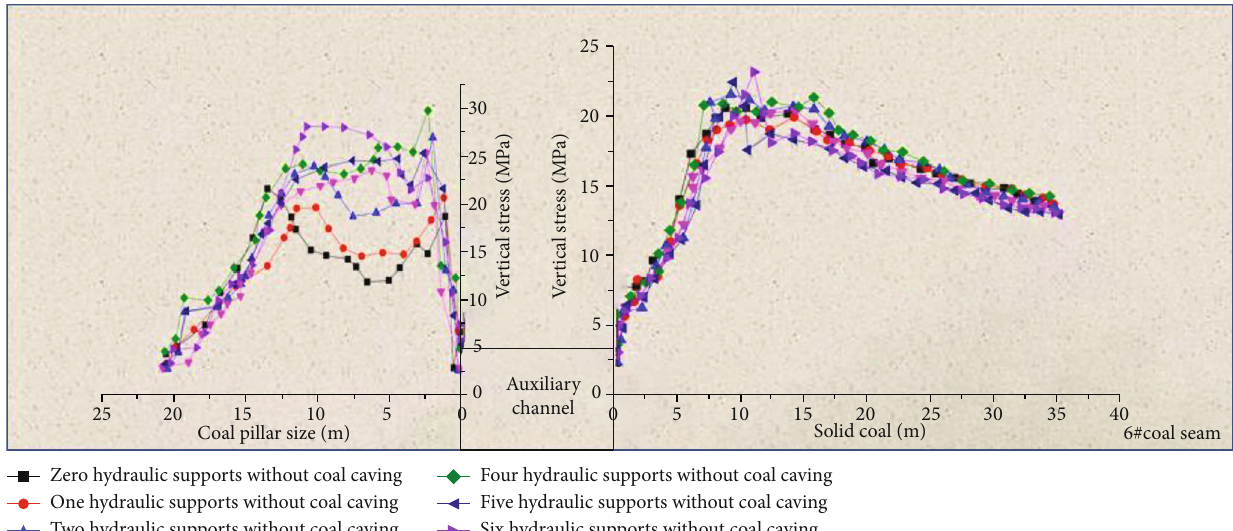
Figure 12: Change of vertical stress of solid coal on the right of coal pillar and roadway with length of end empty section (15 m coal pillar).